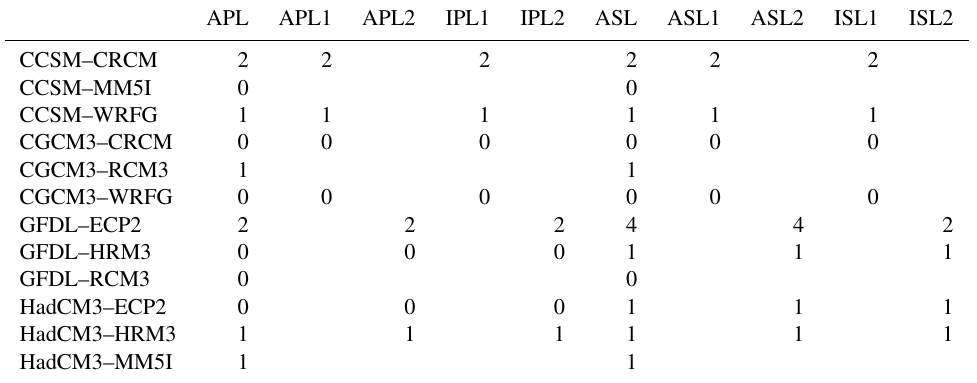
Table 6. The order of the autoregressive model fit to the residuals of each regression model for each GCM–RCM